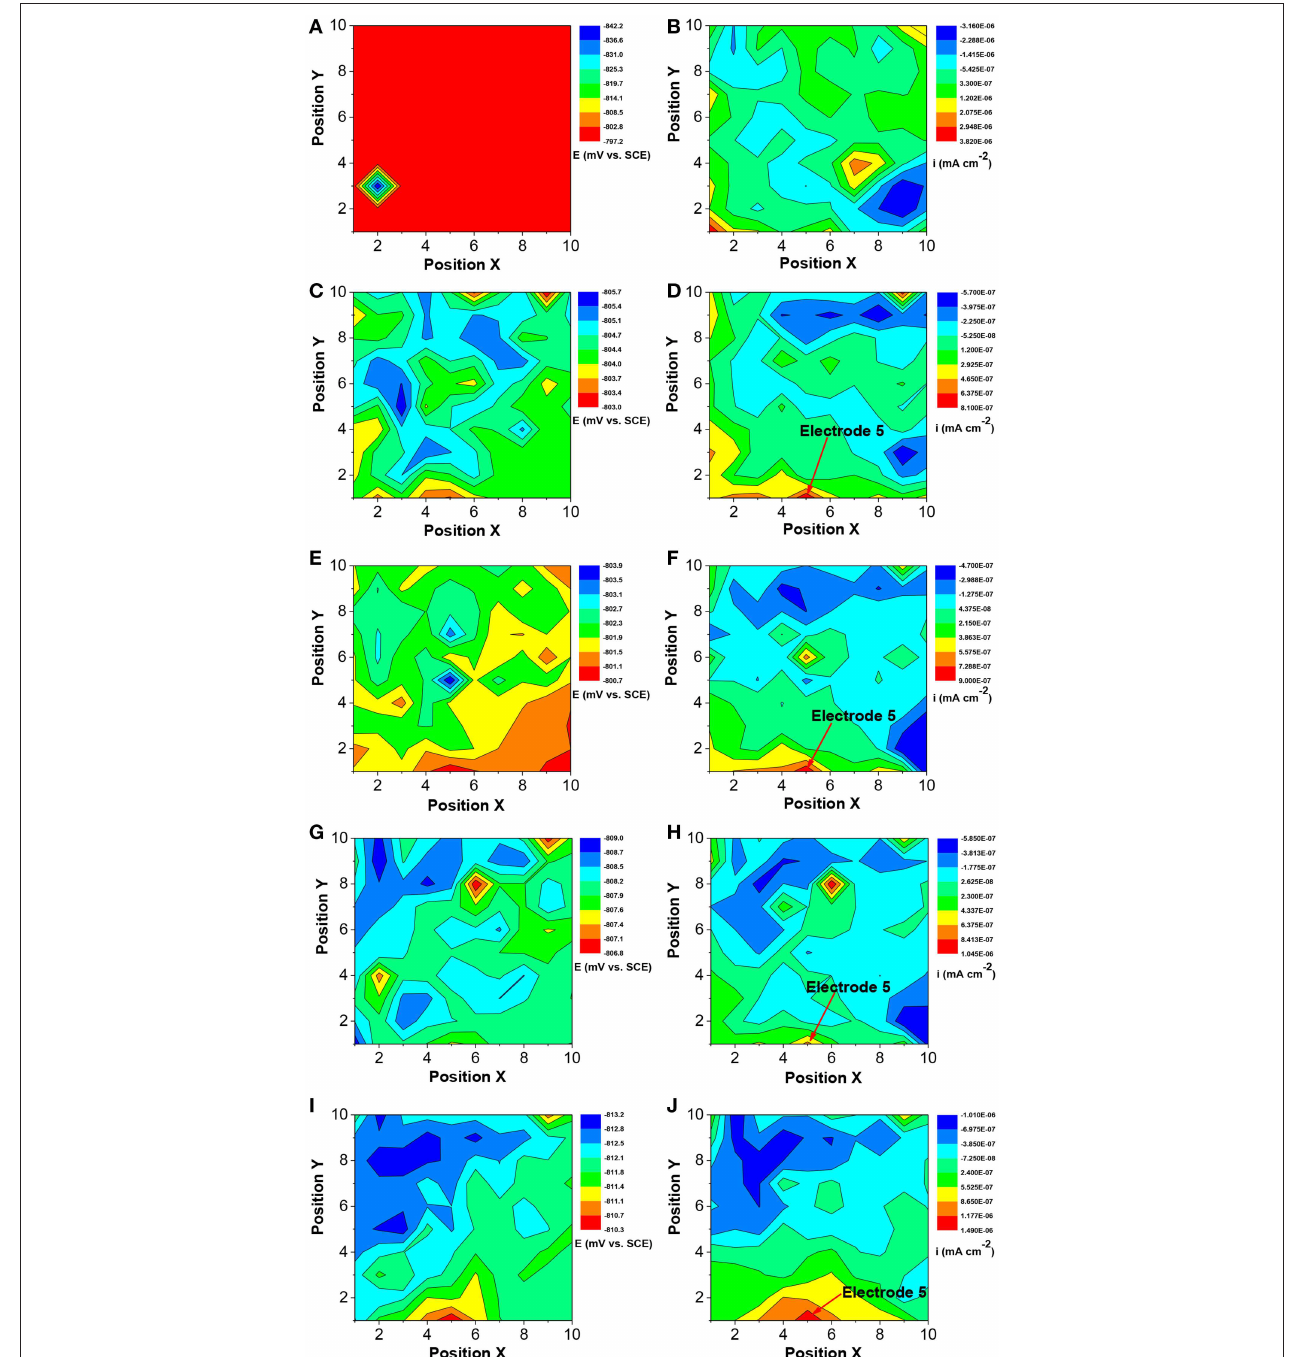
FIGURE 12 | Changes of corrosion potential (A,C,E,G,I) and galvanic current (B,D,F,H,J) distributions of Q235 WBE with incubation time in the absence of SRB in CO 2 -saturated simulated formation water: (A,B) 1 day; (C,D) 4 days; (E,F) 7 days; (G,H) 10 days and (E,F) 14 days.